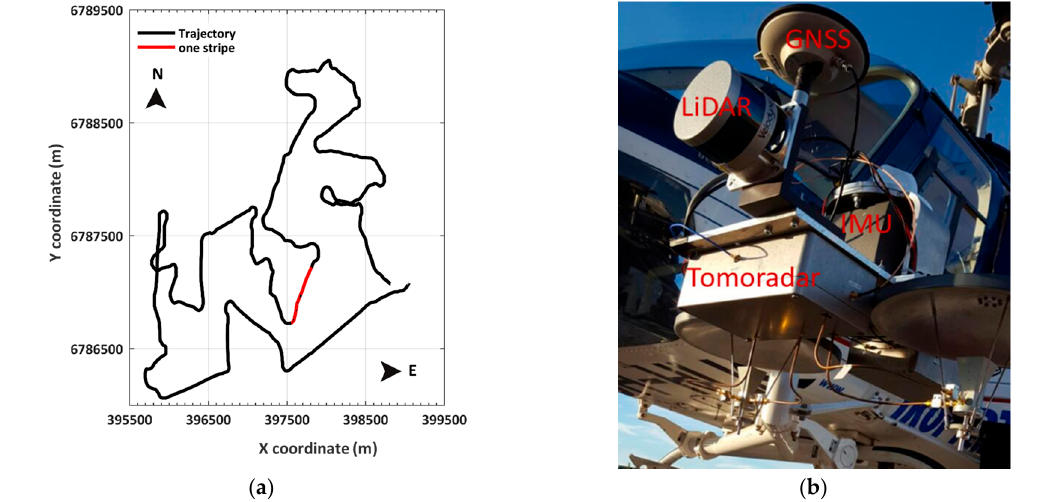
Figure 1. ( a ) Trajectory diagram in the West section of the study area (black line), and a route of investigated data in one stripe (red line). The locations of trajectory are depicted in the local east, north, and up (ENU) coordinates; ( b ) the suites of all instruments on the Bell 206 helicopter: Tomoradar, lidar, and GNSS-IMU.